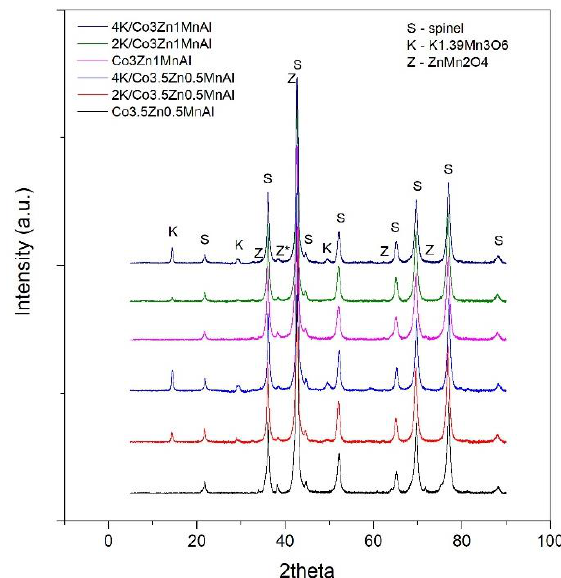
Figure 2. XRD patterns of mixed oxide catalysts, *overlap with spinel β -line.